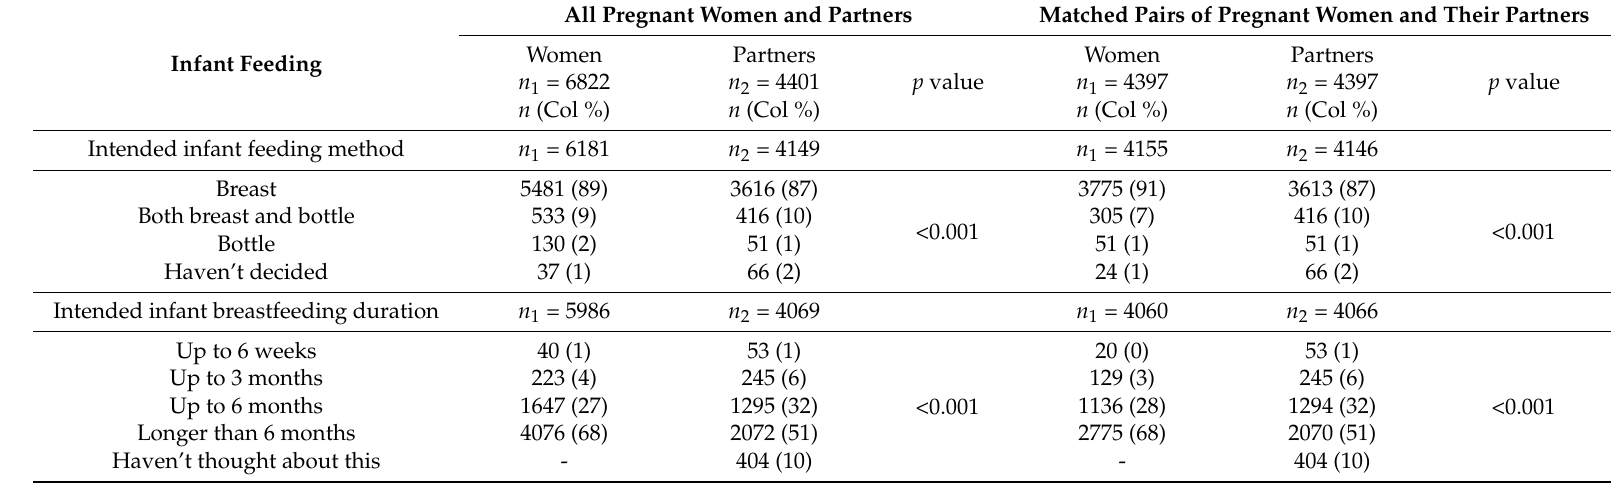
Table 1. Pregnant women and their partner’s intentions for infant feeding.